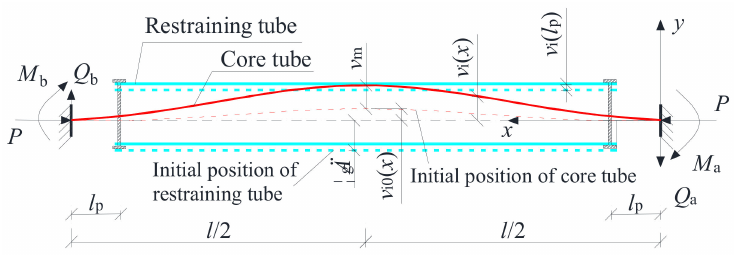
Figure 2. Model of the buckling monitoring